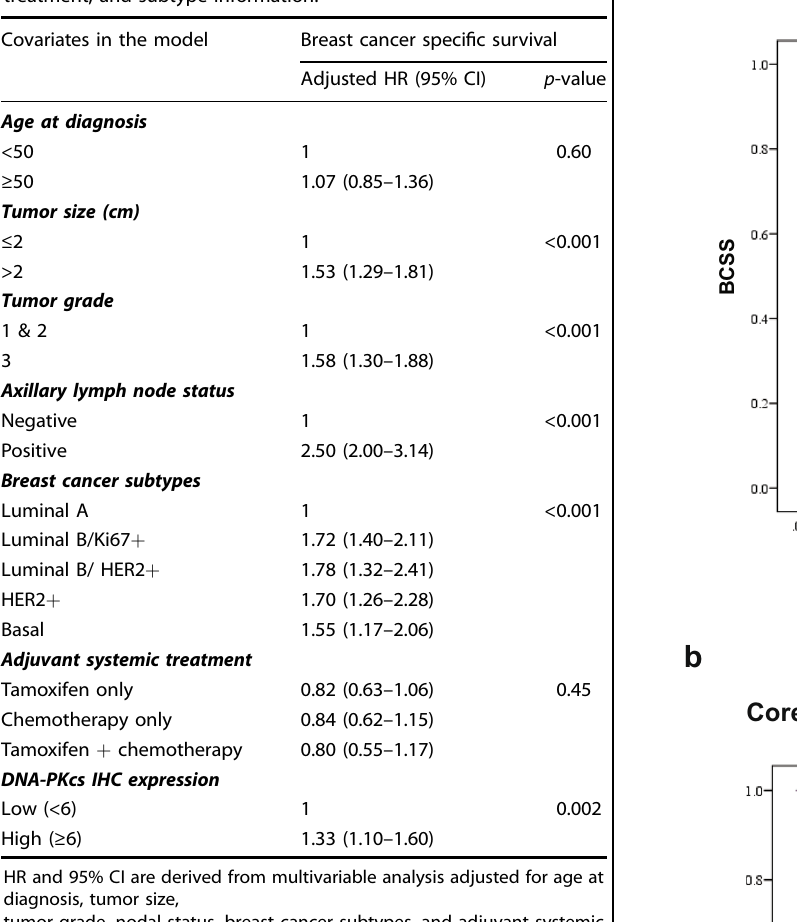
Table 2. Multivariate analysis for DNA-PKcs expression in the British Columbia Cancer series including clinicopathological features, treatment, and subtype information.